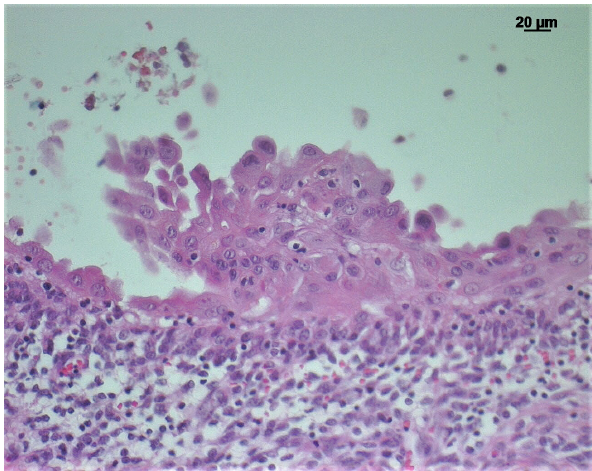
Figure 3. H&E-stained section of the jejunum of an African green monkey with reactive mesothelial hyperplasia: papillary projection of mesothelial cells on the intestinal serosa and subserosal inflam- matory cell infiltration underneath.